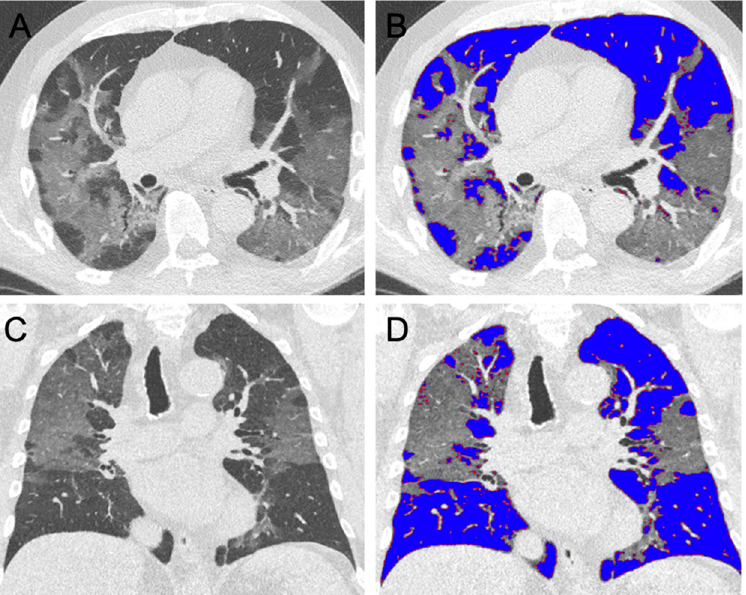
Figure 3. Axial ( A , B ) and coronal ( C , D ) reformations of the chest CT of a 78-year-old-male patient presenting with mild dyspnea. Radiological severity grade 4 was assigned. Forty-five percent of the lung volume is affected by characteristic parenchymal changes, most prominent in the right upper lobe (shaded blue in B and D).